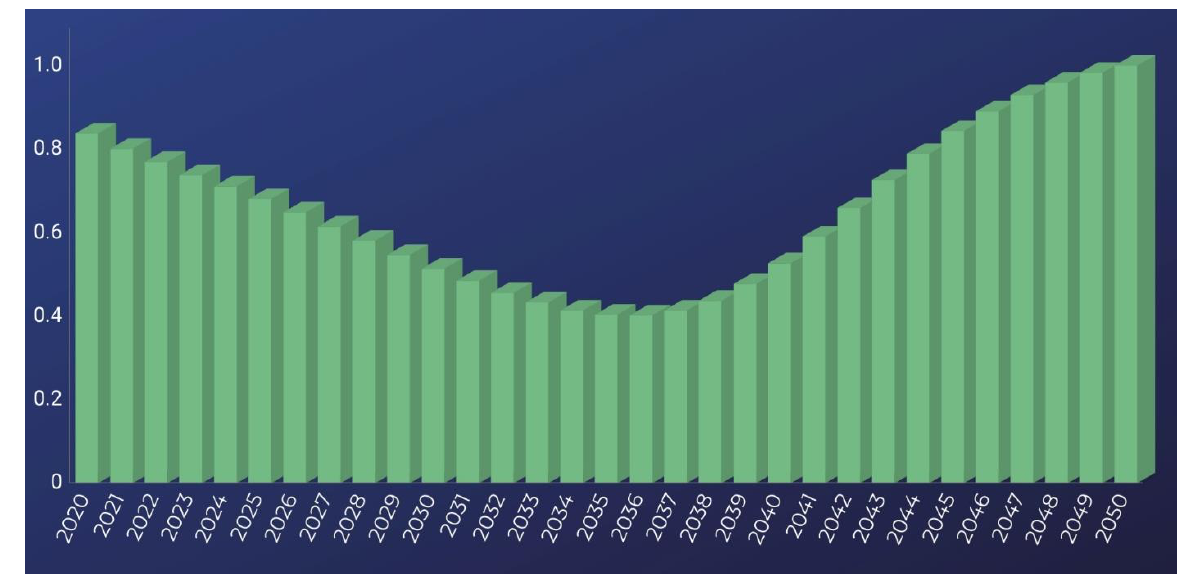
Figure 7. Scale efficiency of green hydrogen production in the UAE.